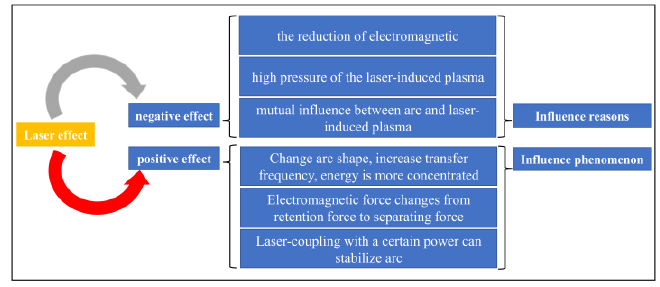
Figure 19. The effect of laser on droplet transfer in LAHW.